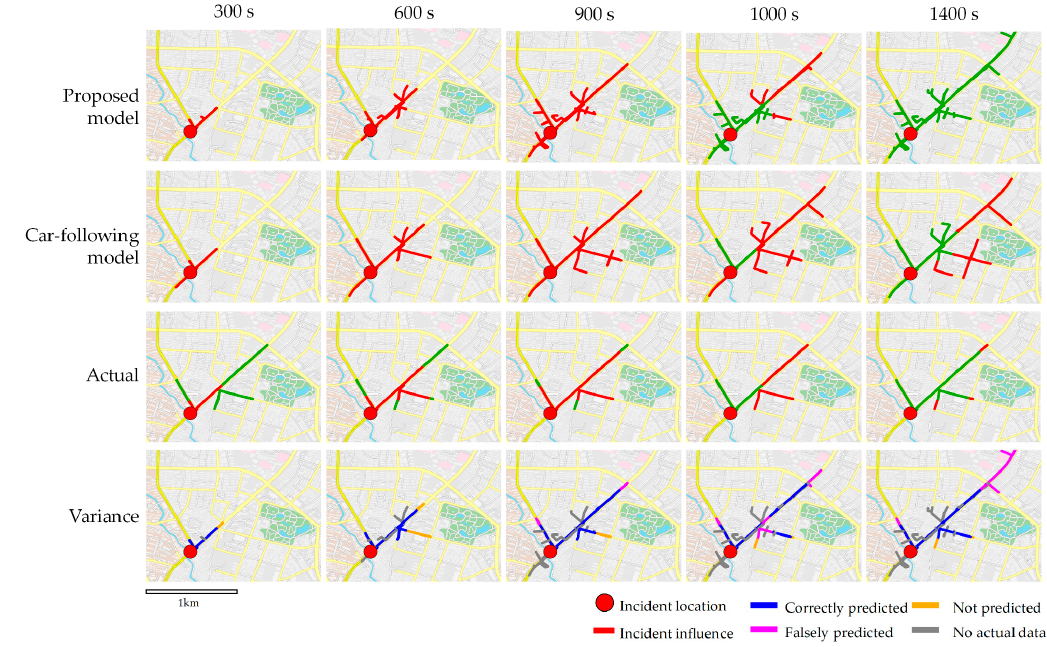
Figure 9. Spatiotemporal diagrams comparing the result of the proposed model, car-following model and actual data for Case A. The variance between the proposed model and truth is shown in the fourth row.